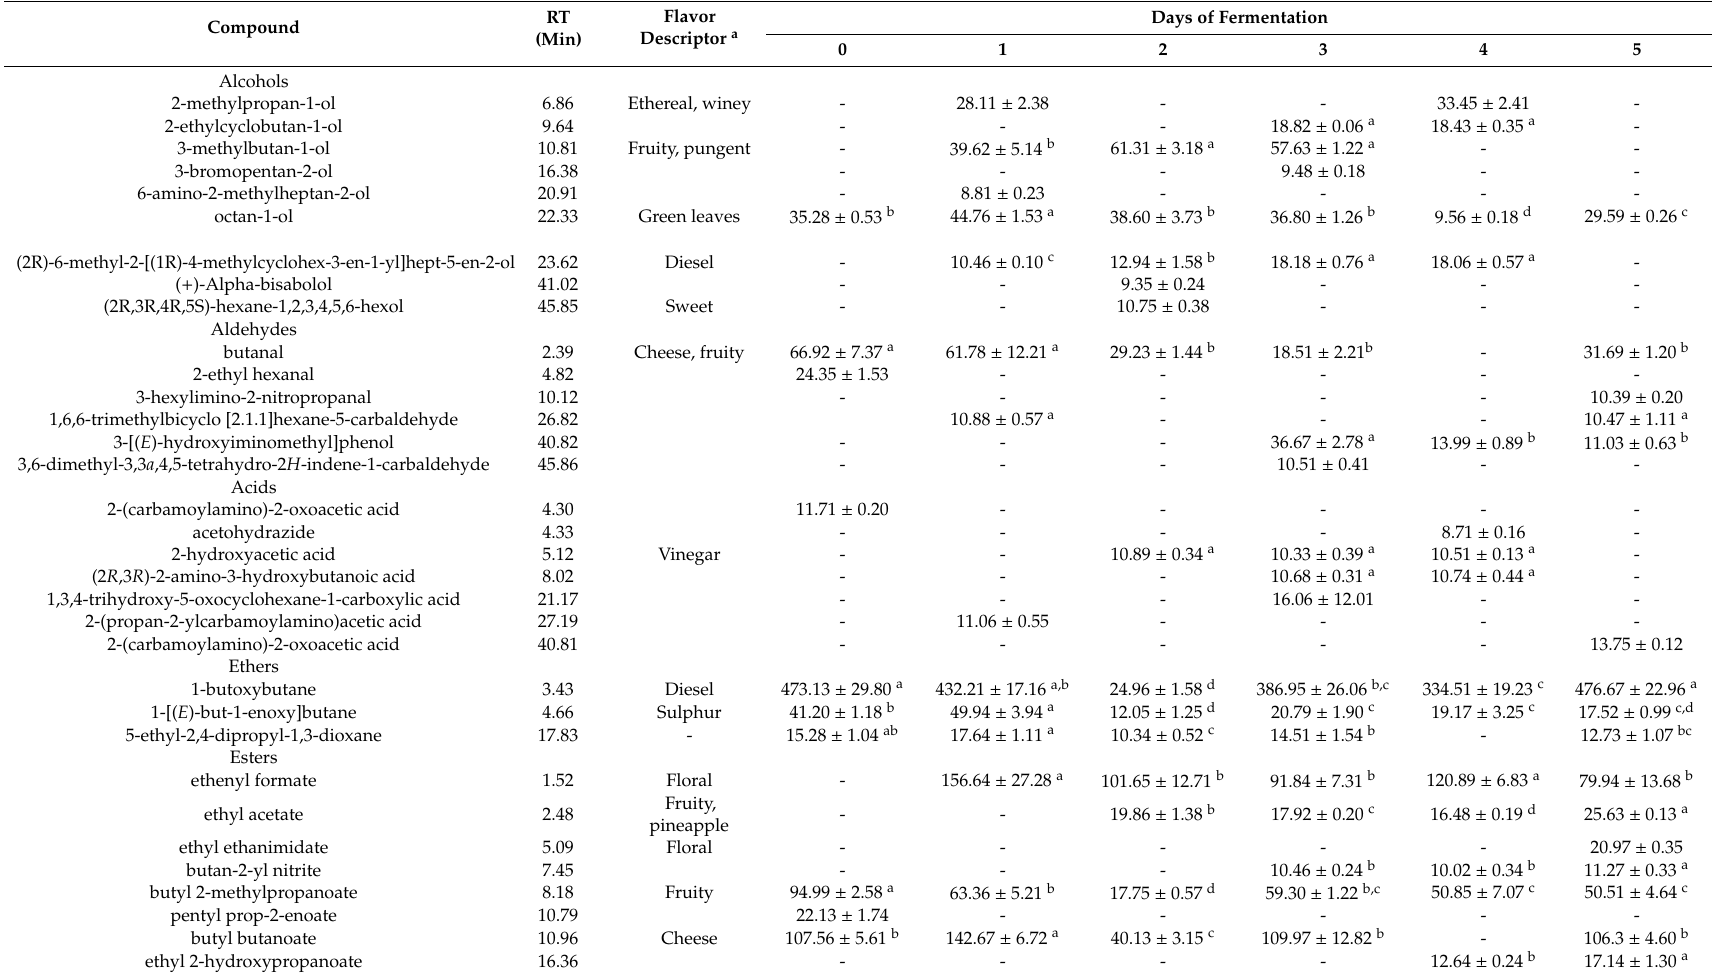
Table 1. The concentration of volatiles in fermented sotol ( Dasylirion sp) must (mg / L). Mean ± STD (n = 3).